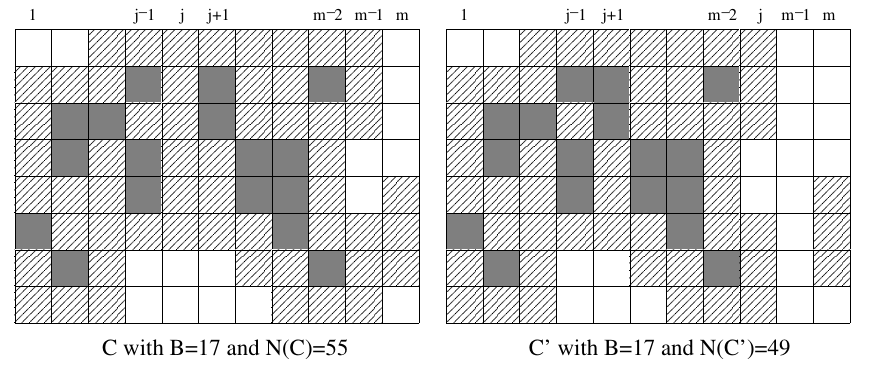
Fig. 2: The effect of putting the empty columns